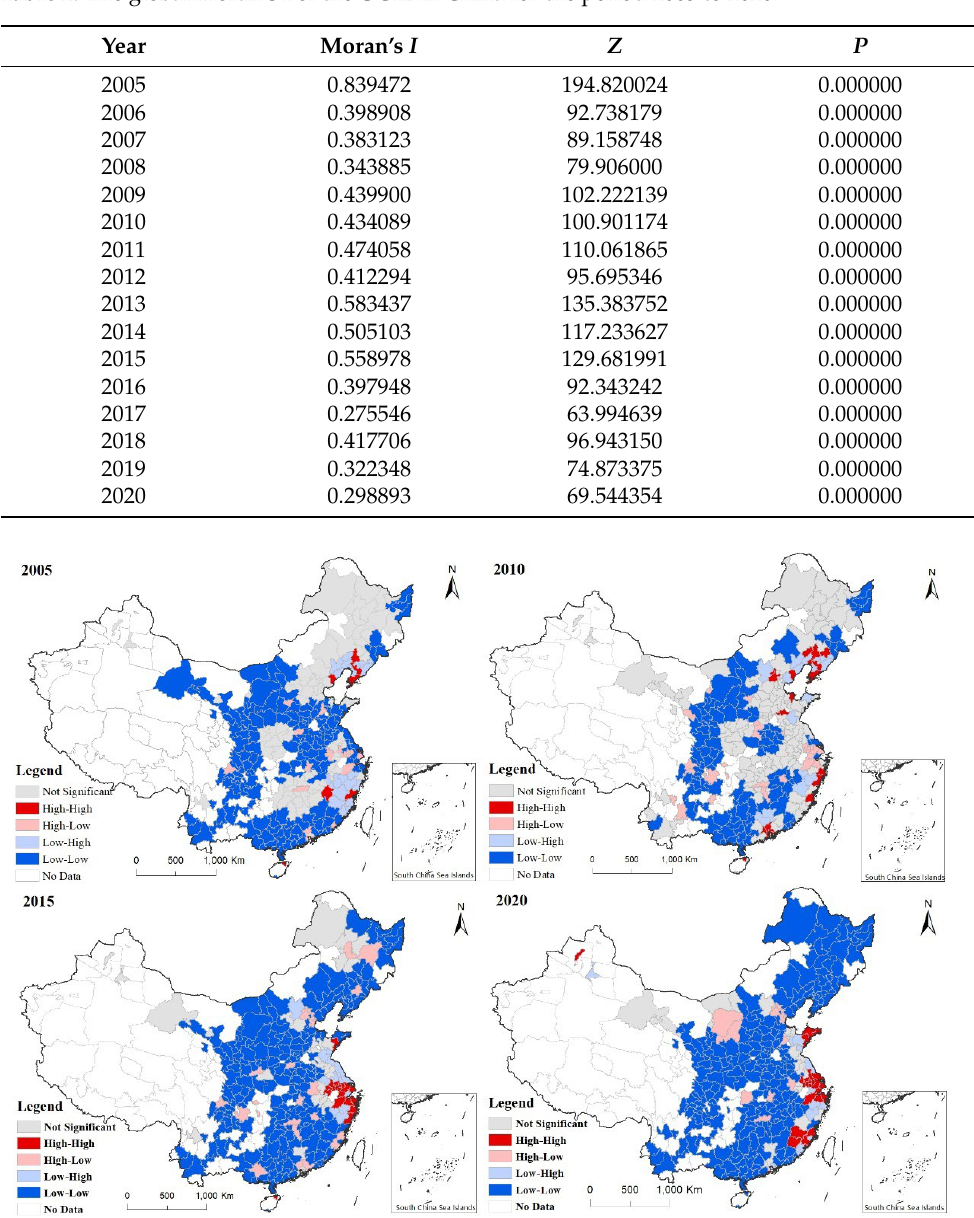
Table 2. The global Moran’s I of the UGIE in China for the period 2005 to 2020.